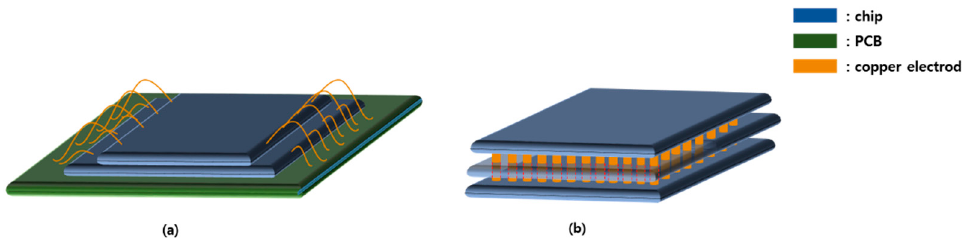
Figure 1. Two types of 3D lamination process: ( a ) wire bonding, ( b ) through-silicon via (TSV).